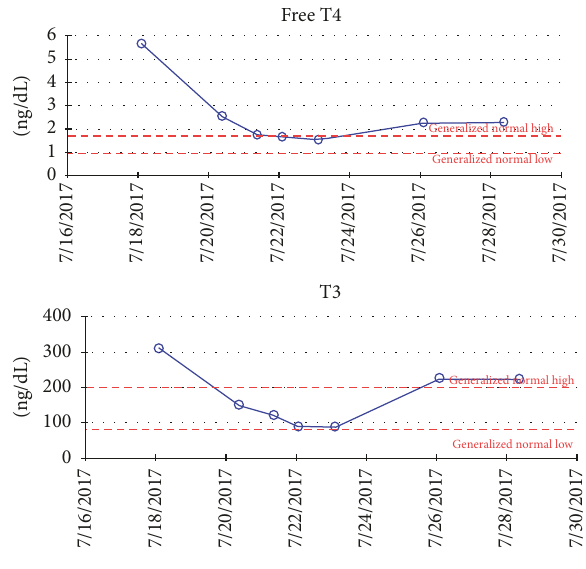
Figure 2: Free T4 and T3